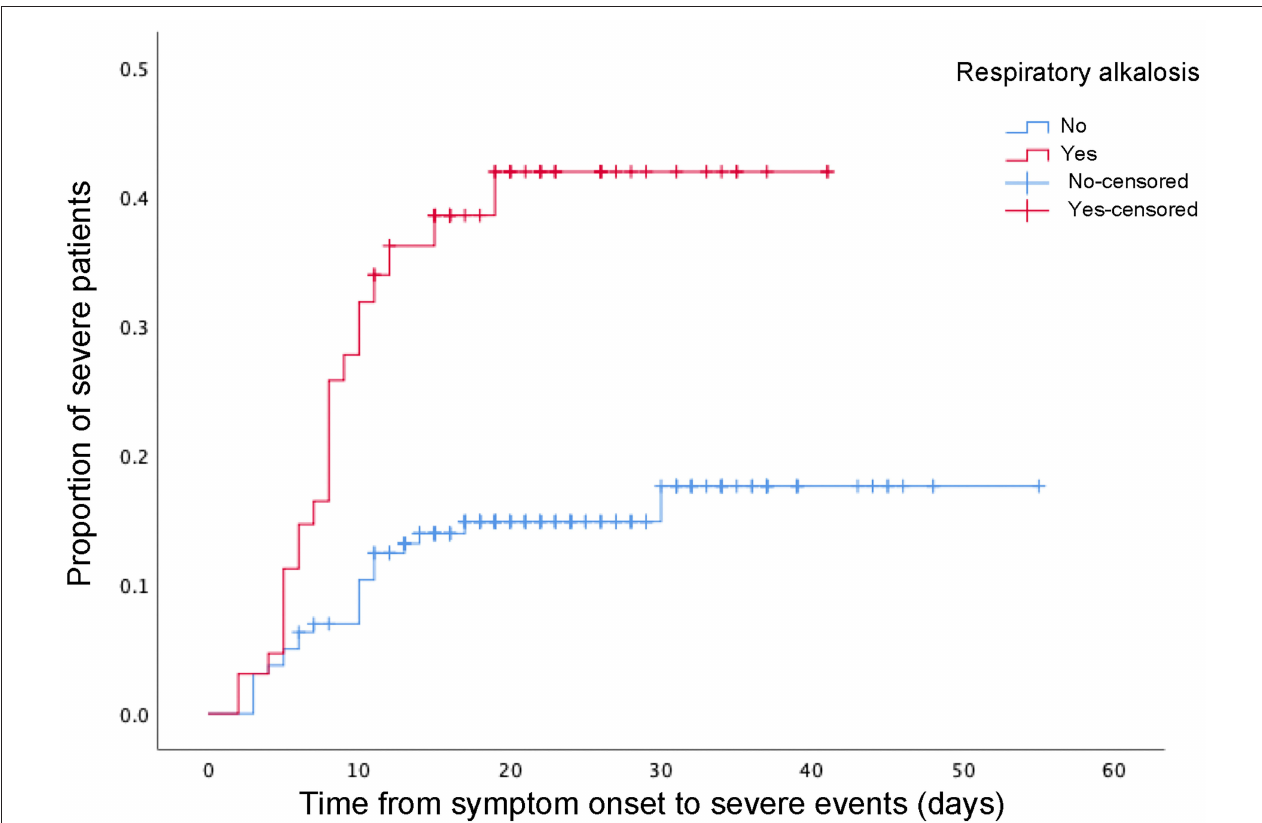
FIGURE 1 | The time-dependent risk of reaching to severe events in COVID-19 patients with or without respiratory alkalosis using Kaplan-Meier analysis and log rank-test. COVID-19, coronavirus disease 2019.